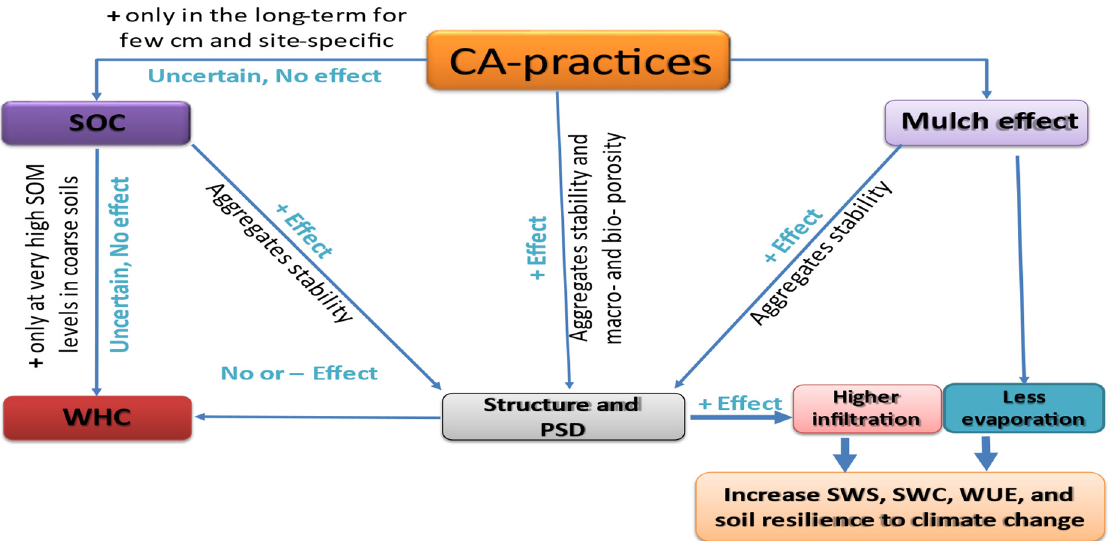
Figure 3. Flowchart of CA-practices contribution to soil organic carbon (SOC), water holding capacity (WHC), soil structure, pore size distribution (PSD), and soil water content (SWC) and storage (SWS).